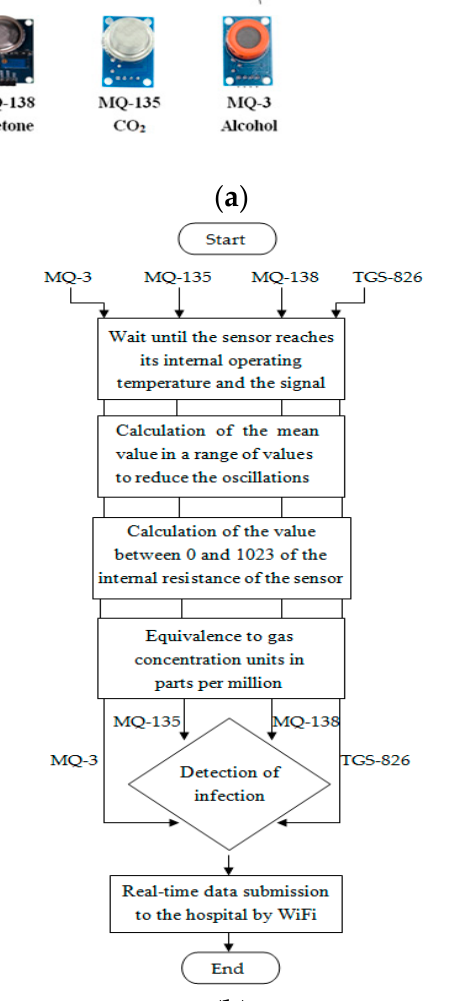
Figure 2. ( a ) system design; ( b ) high level schema for bacteria detection using four gas sensors.